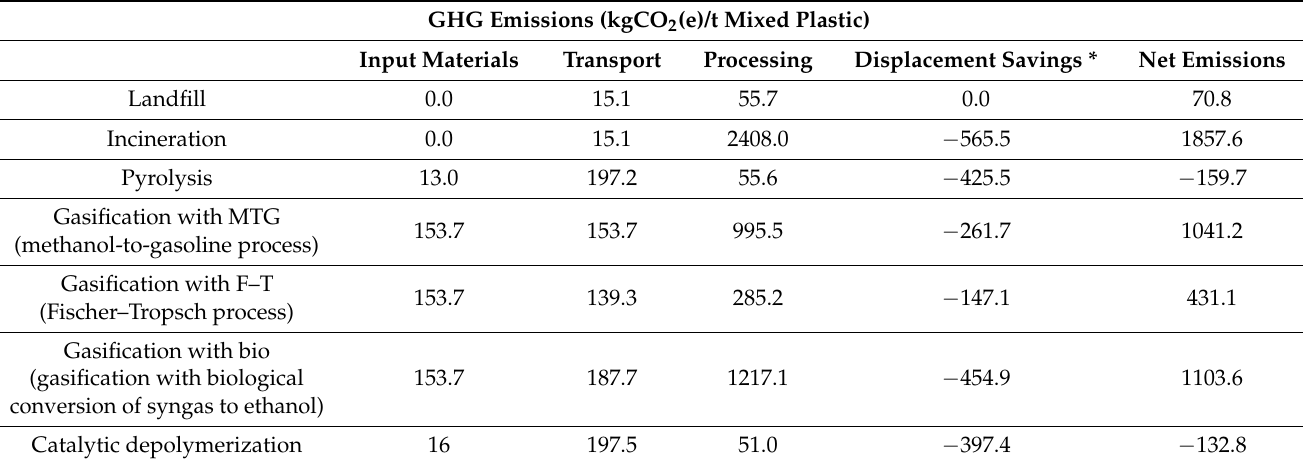
Table 2. Net emissions factors for plastics for different materials management options